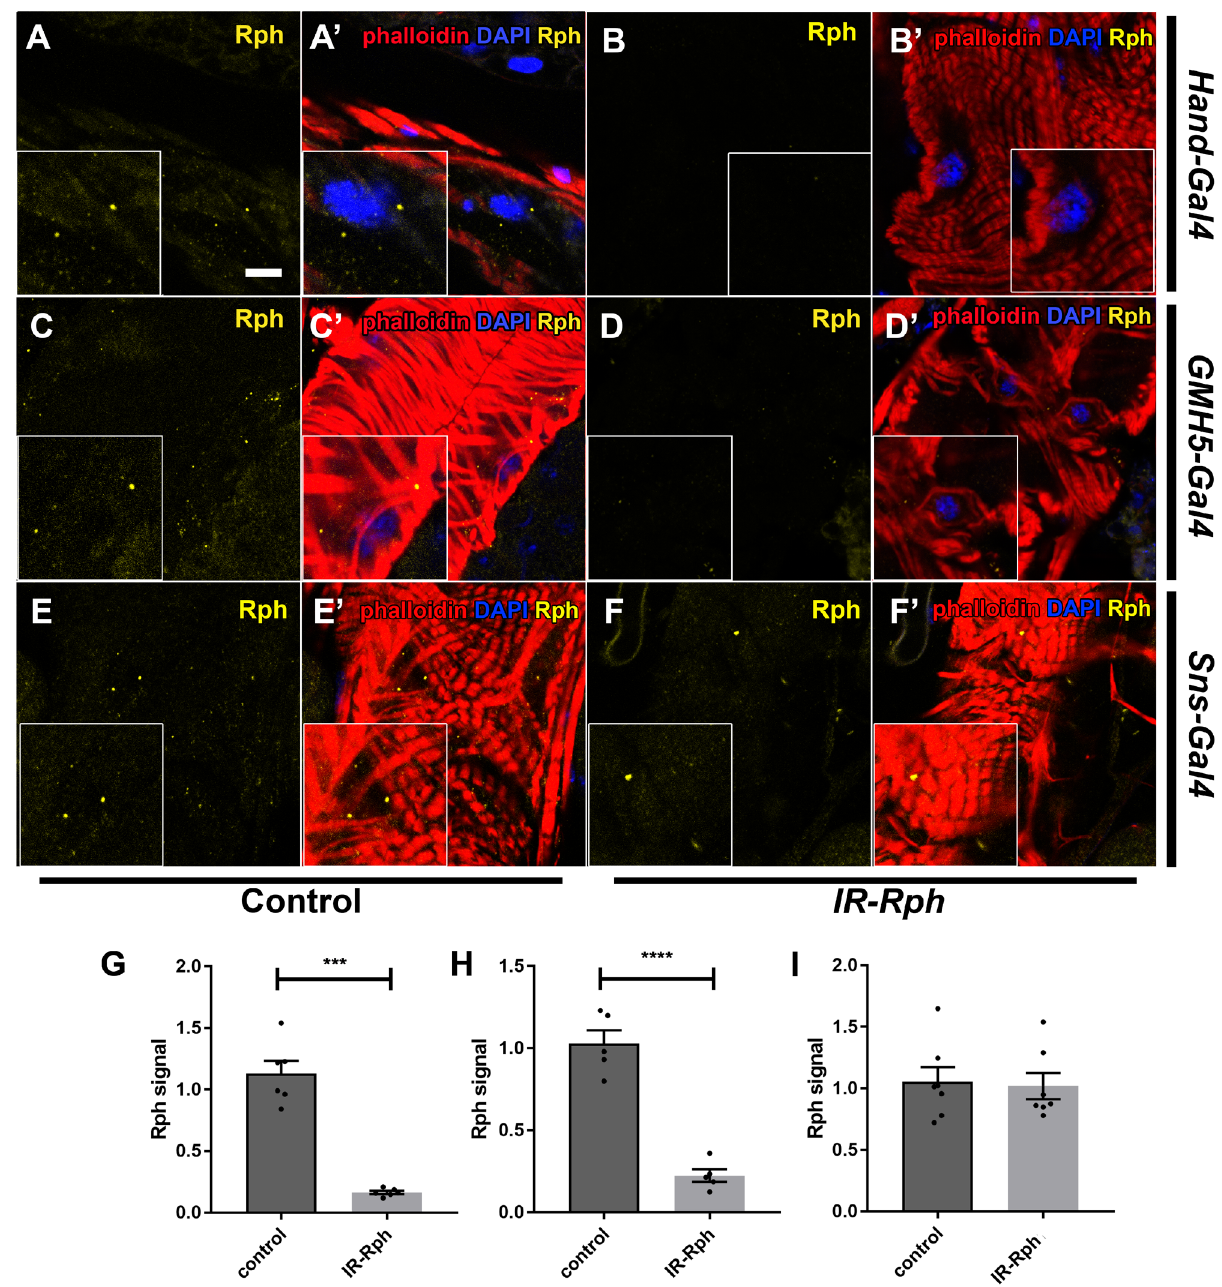
Figure 1. Rabphilin is expressed in adult Drosophila cardiomyocytes and Rph signal is decreased by expression of UAS-IR-Rabphilin line 1 construct. Representative confocal images of adult control ( A, A ′ , C, C ′ , E, E ′ ) and flies expressing UAS-IR-Rabphilin line 1 ( IR-Rph , B, B ′ , D, D ′ , F, F ′ ) under the control of the Hand-Gal4 ( A, A ′ , B, B ′ ), GMH5-Gal4 ( C, C ′ , D, D ′ ) and Sns-Gal4 ( E, E ′ , F, F ′ ) driver. Immunostaining with the anti- Rabphilin antibody (in yellow) showed Rph presence in the heart of all control flies and IR-Rph flies driven by the Sns-Gal4 line ( F, F ′ ). Rph signal was importantly reduced by the expression of the Rph interference construct line 1 in cardiomyocytes using Hand-Gal4 and GMH5-Gal4 drivers ( B, B ′ , D, D ′ ). Rph relative signal from flies expressing IR-Rph line 1 construct under Hand-Gal4 , GMH5-Gal4 and Sns-Gal4 is shown in G , H , I , respectively. Nuclei were counterstained with DAPI (blue) and phalloidin (red) was used to stain actin filaments of the Drosophila heart. Images correspond to the A4 segment of the Drosophila abdomen and scale bar = 10 µm. Student’s t-test. *** p value < 0.001, **** p value < systolic diameters (EDD and ESD, respectively) were also greater than in controls in IR-Rph flies, but not in the case of EDD with IR-Rph2 flies, which did not change compared to controls (Fig. 4C). The fractional shortening (FS) showed a trend towards reduction, not being significant in IR-Rph1 flies but showing a significant reduction